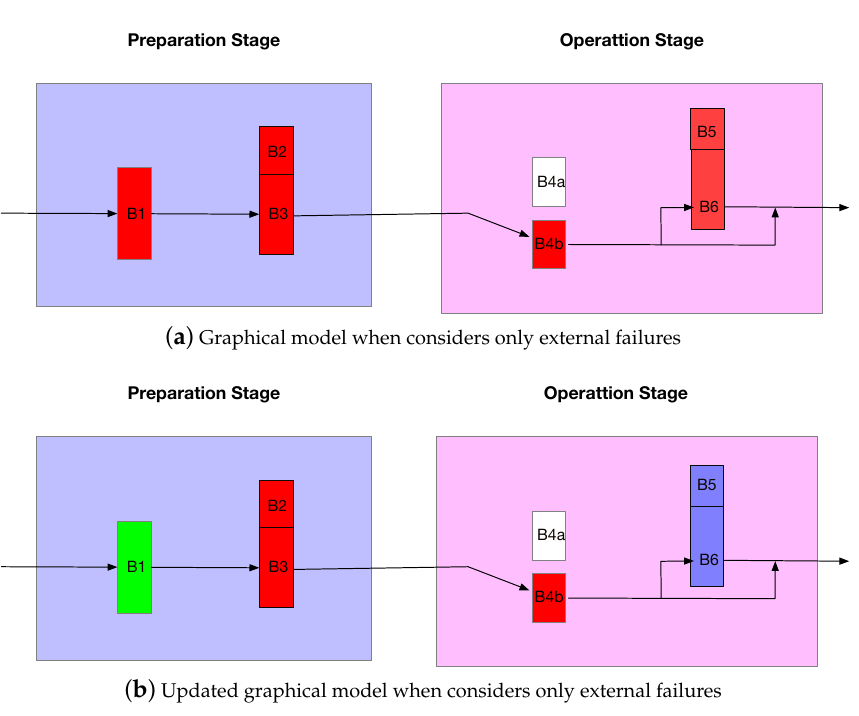
Figure 9. Updated graphical model with the safety potential under each scenario (please refer to Table